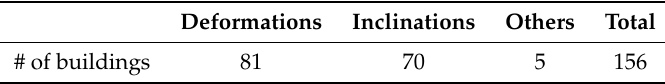
Table 3. The reasons for the